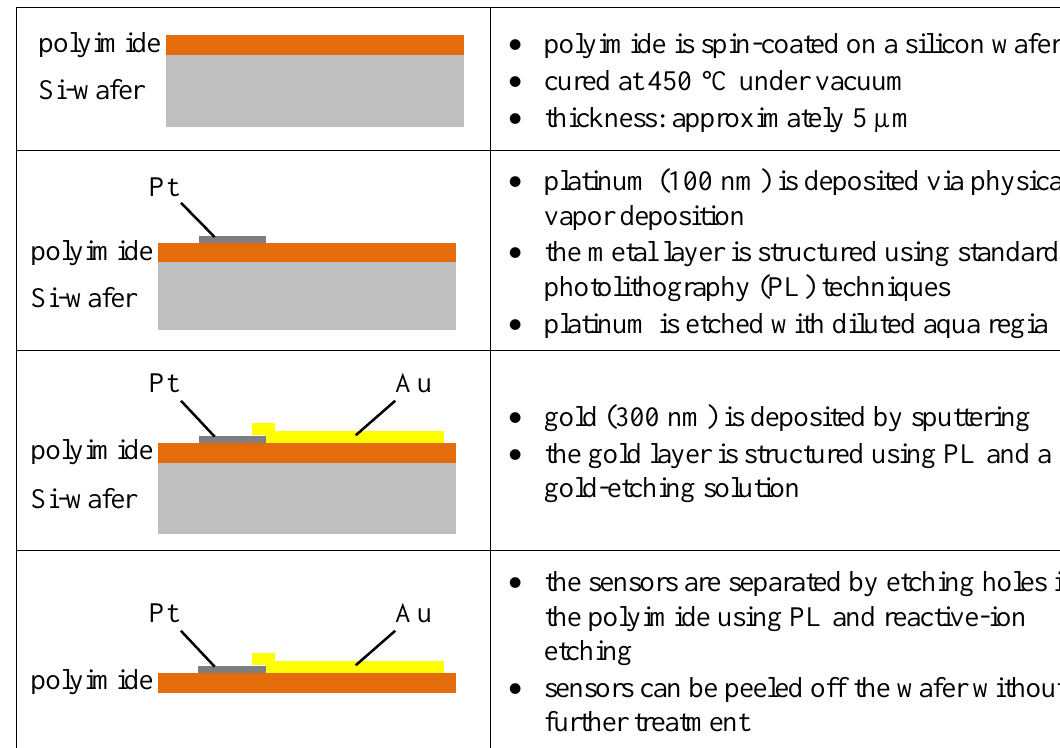
Figure 3. Summary of the processing steps of the sensor.